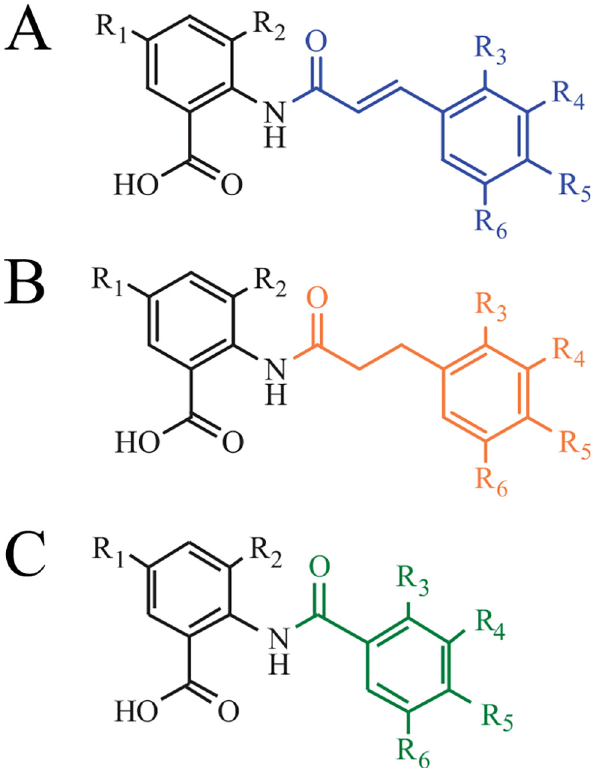
Fig 1. Structure of cinnamoyl, dihydrocinnamoyl, and benzoyl anthranilates. (A) Cinnamoyl anthranilates. Tranilast: R 1 = R 2 = R 3 = R 6 = H, R 4 = R 5 = OMe. (B) Dihydrocinnamoyl anthranilates.